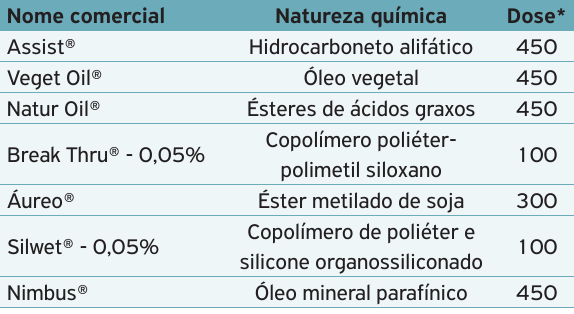
Tabela 1. Nome comercial, natureza química e dose dos adjuvantes